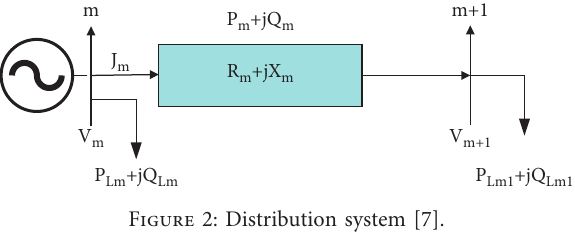
Figure 2: Distribution system